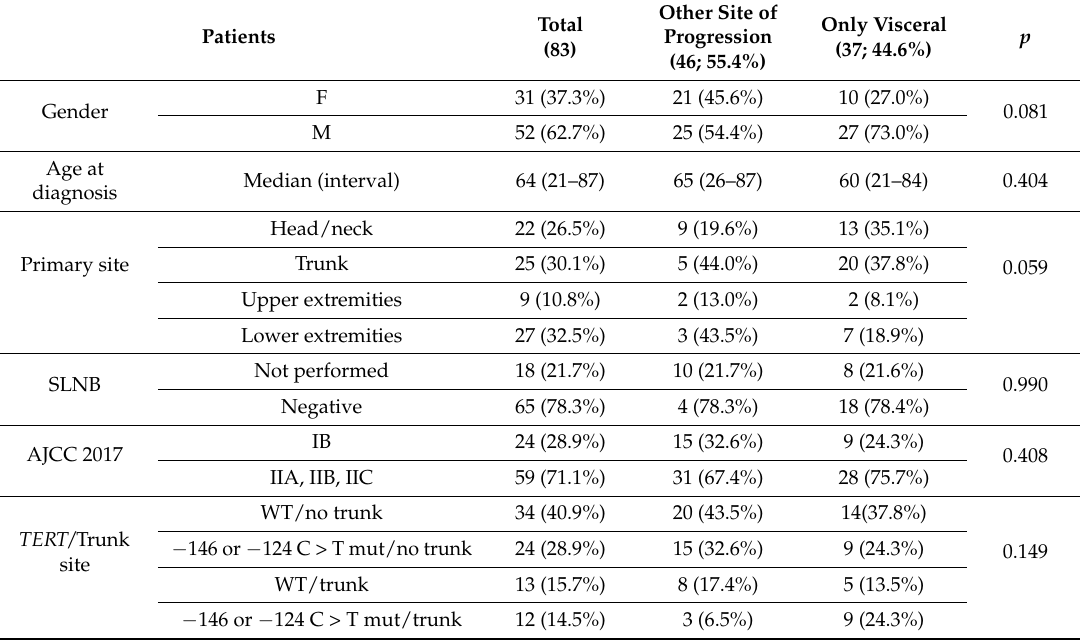
Table 6. Clinical characteristics of Istituto Valenciano de Oncologia dataset based on pattern of first